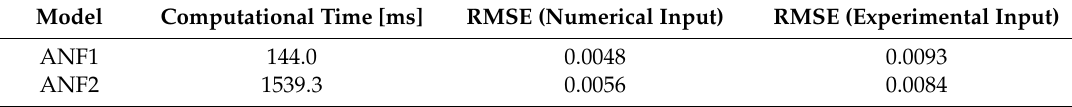
Table 2. Comparison of accuracy and computational time for obtained ANFIS models.